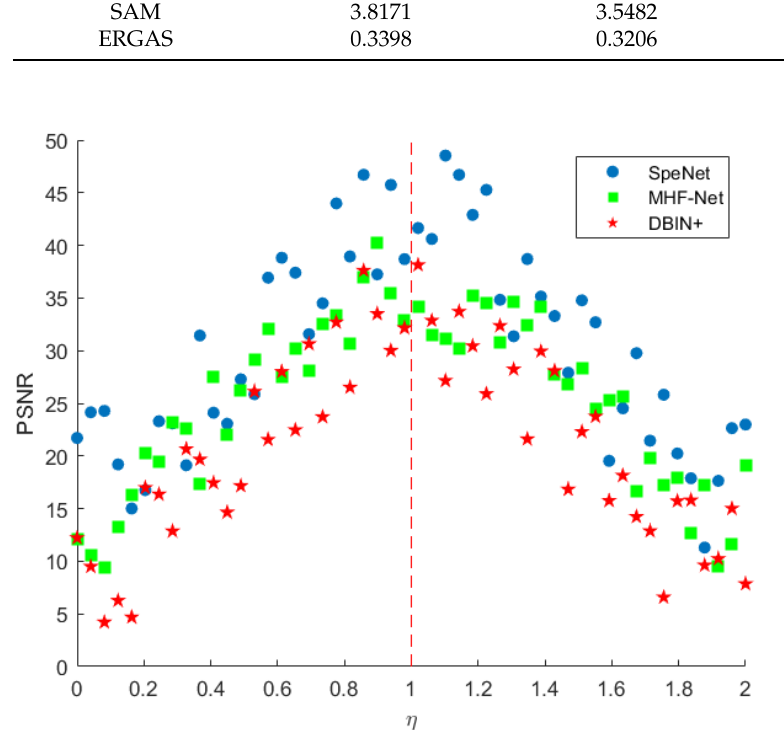
Figure 2. The relationship between the normalized PSNR and the active residual activity factor η at different stages of the residual learning